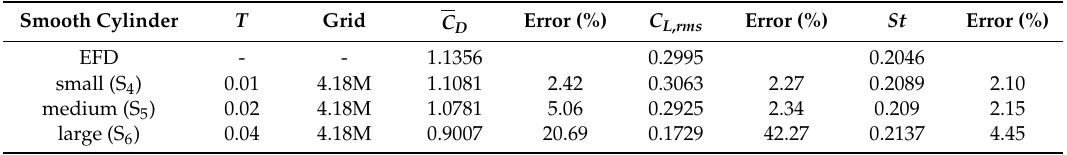
Table 2. Time–step independence verification on smooth